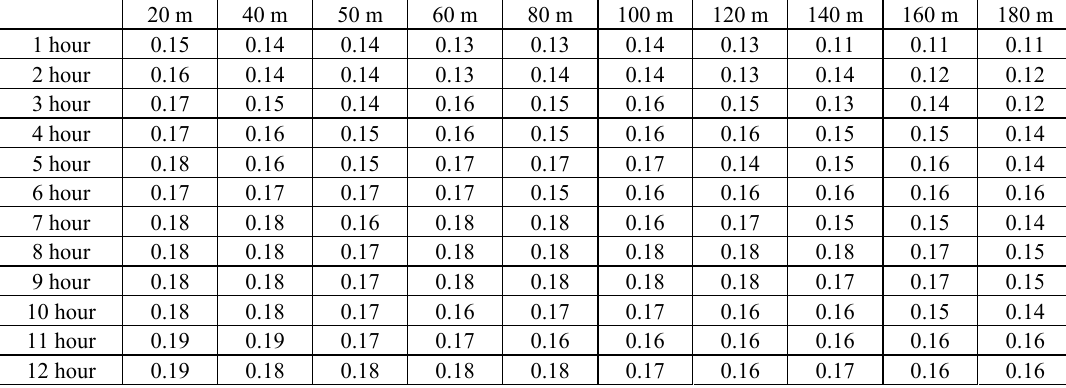
Table 1. Mean absolute percentage error (MAPE) at different heights and different prediction hours.